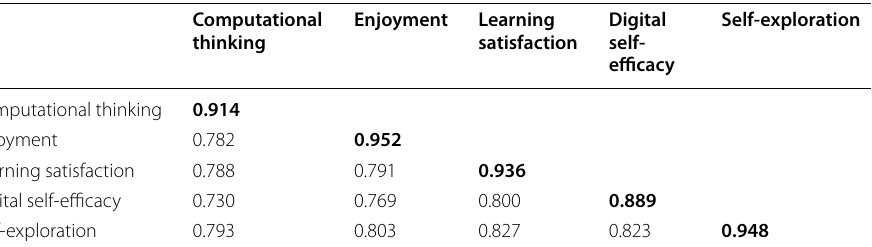
Table 2 Correlation among the construct